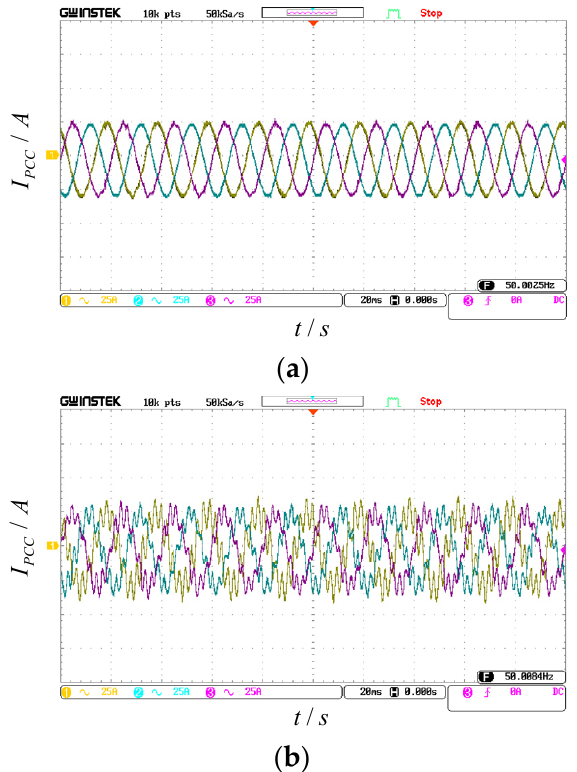
Figure 25. Experimental result of current waveform at PCC with and without parallel compensation capacitors: ( a ) Without parallel compensation capacitors, ( b ) With parallel compensation capacitors.